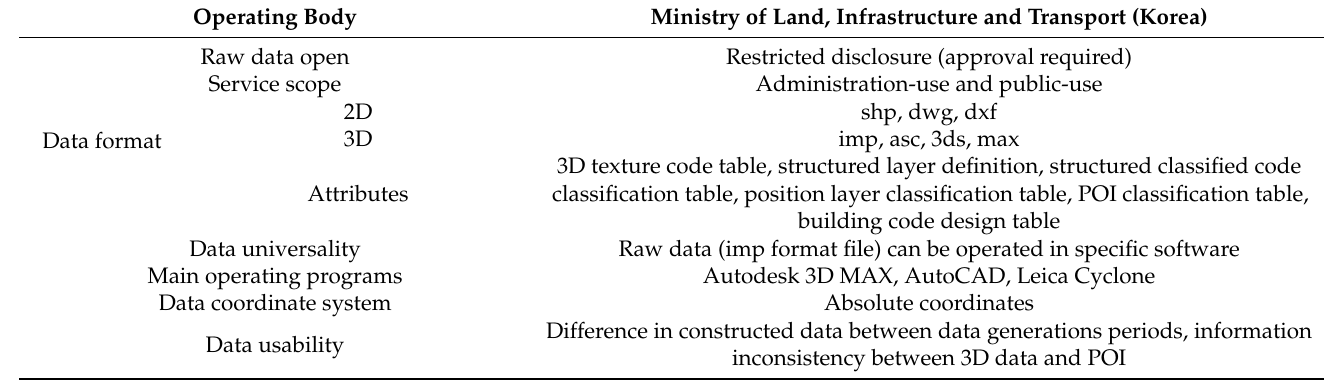
classification table, position layer classification table, POI classification table, building code design